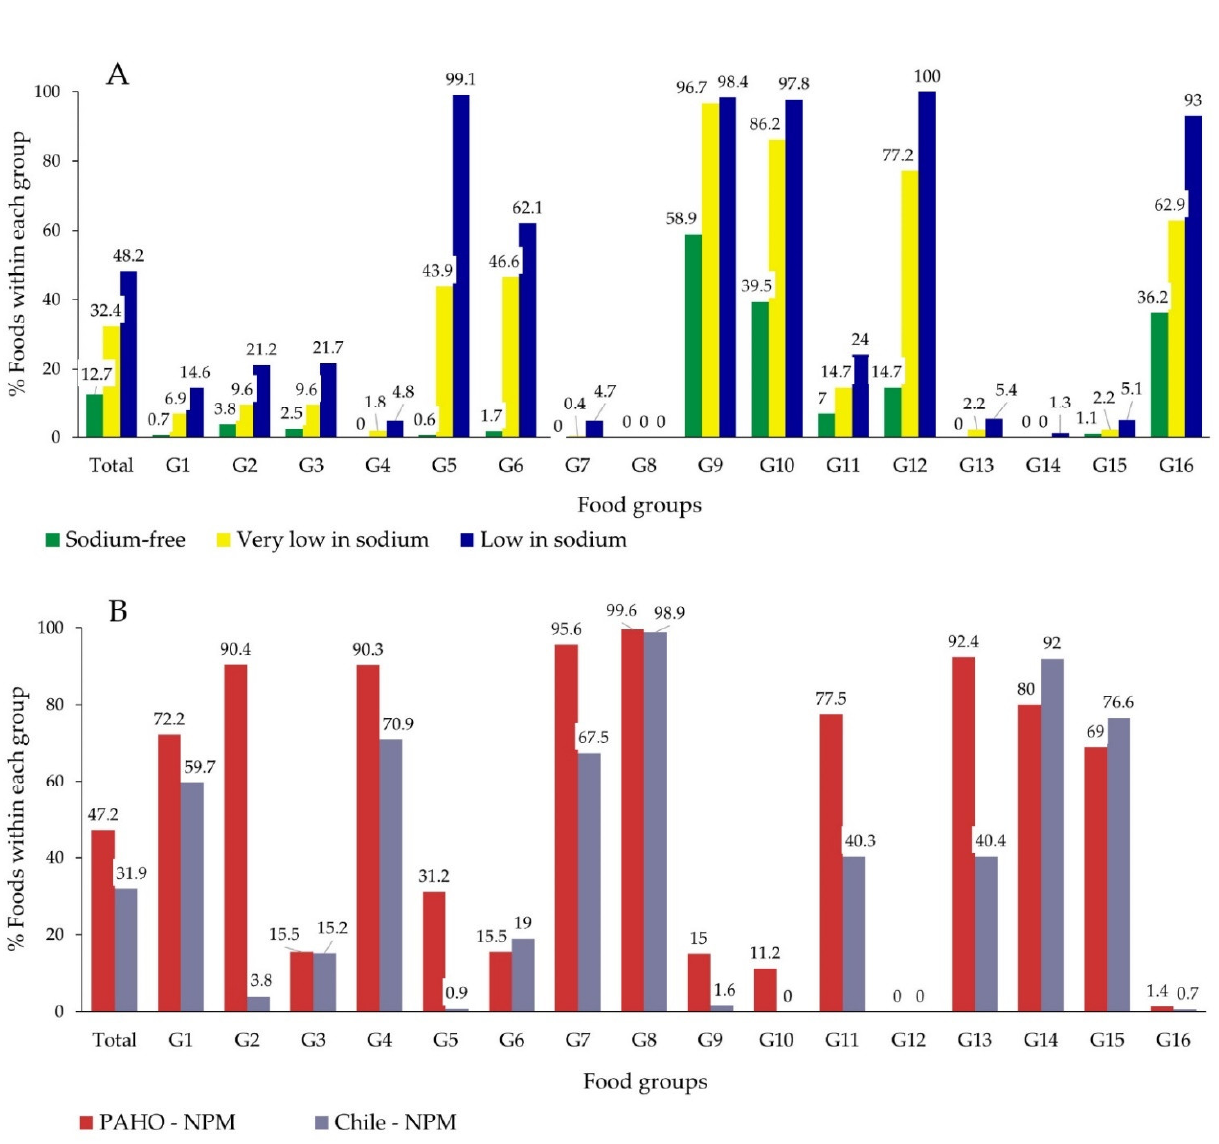
Figure 1. Foods in conformity with the nutrition claims regulated by the European Regulation No 1924/2006 [39] and the Codex Alimentarius [40] ( A ) or exceeding the NPMs thresholds ( B ) for sodium, by group.